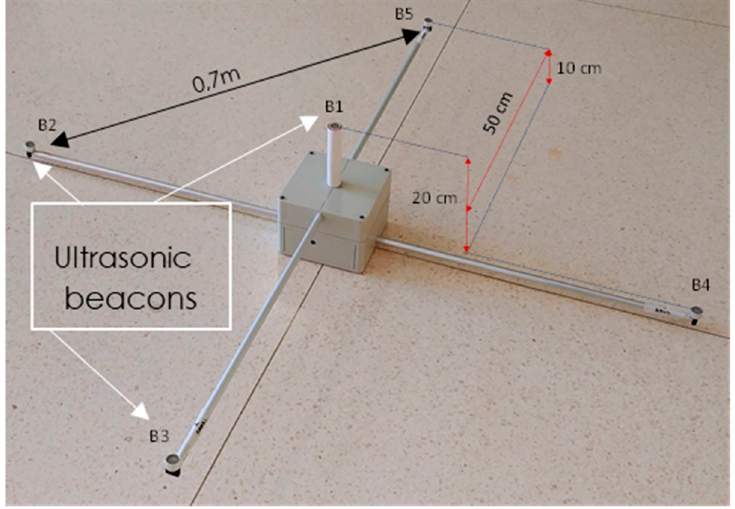
Figure 2. General view of LOCATE-US ULPS unit.